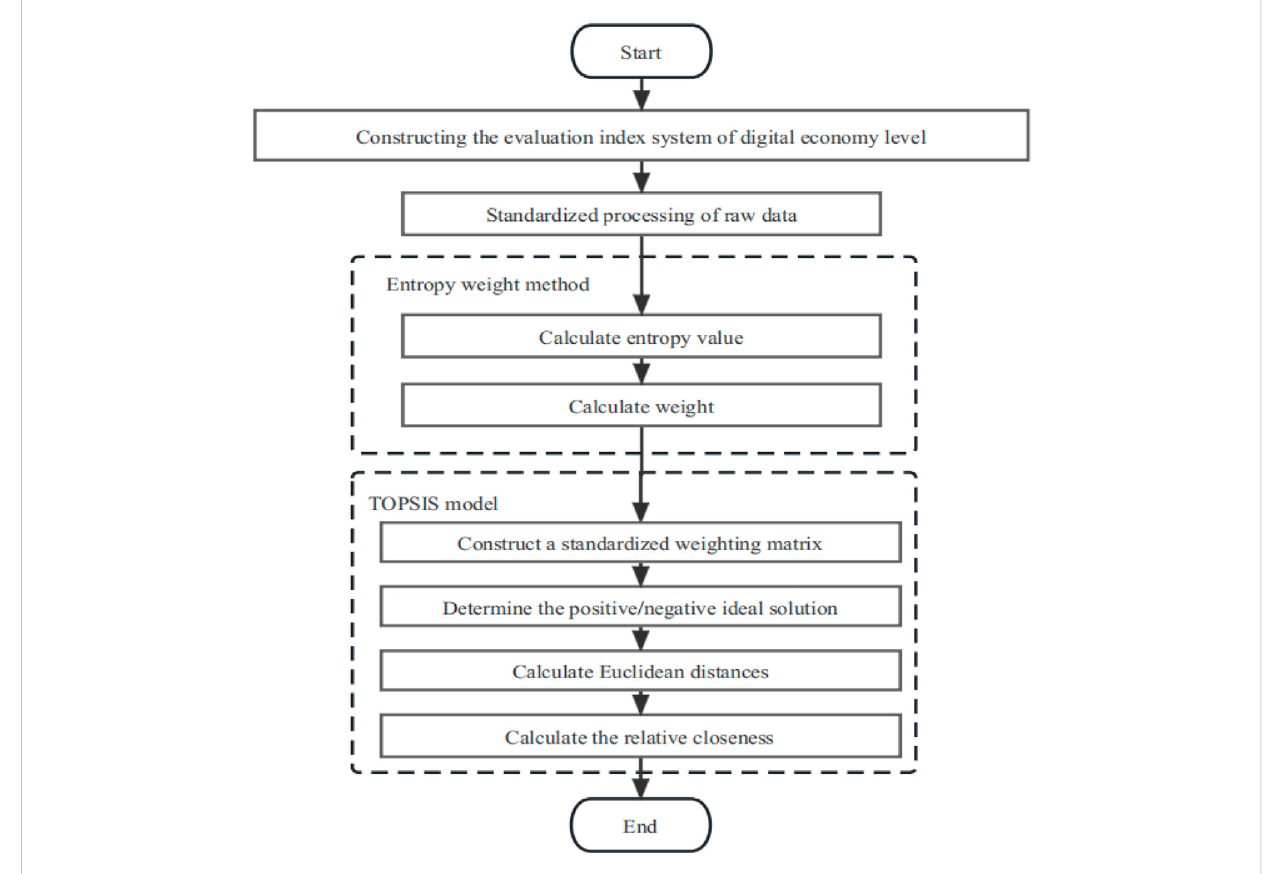
FIGURE 1 Entropy – TOPSIS